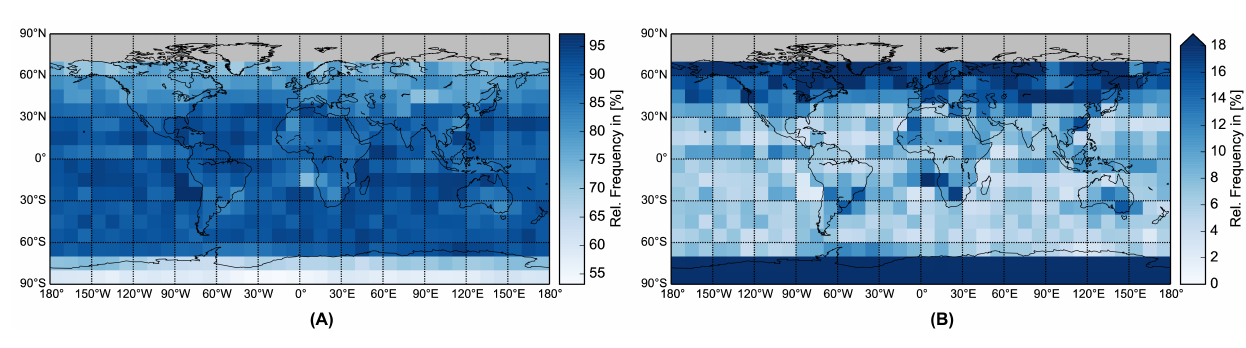
Figure 3. Relative frequencies of aerosols and clouds combined ( | CAD |≥ 70) ( A ) and of no–confidence range (NCR); ( B ) for August